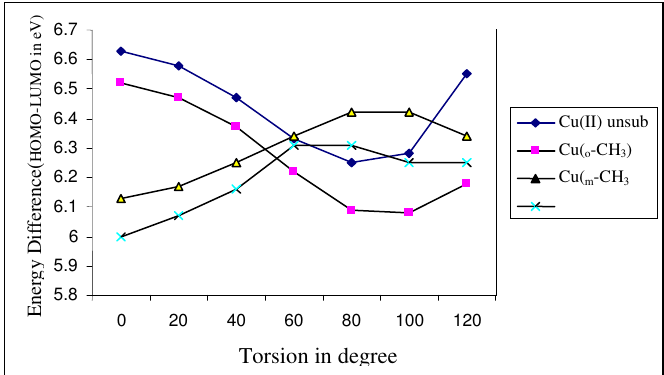
H CON ] 32+ . 6 7 2 H CON ] 22+ , the 6 7 2 H CON ] 32+ in that there is a decrease in ∆ gap as the 6 7 2 substituent has 3 substituted which increased. 3